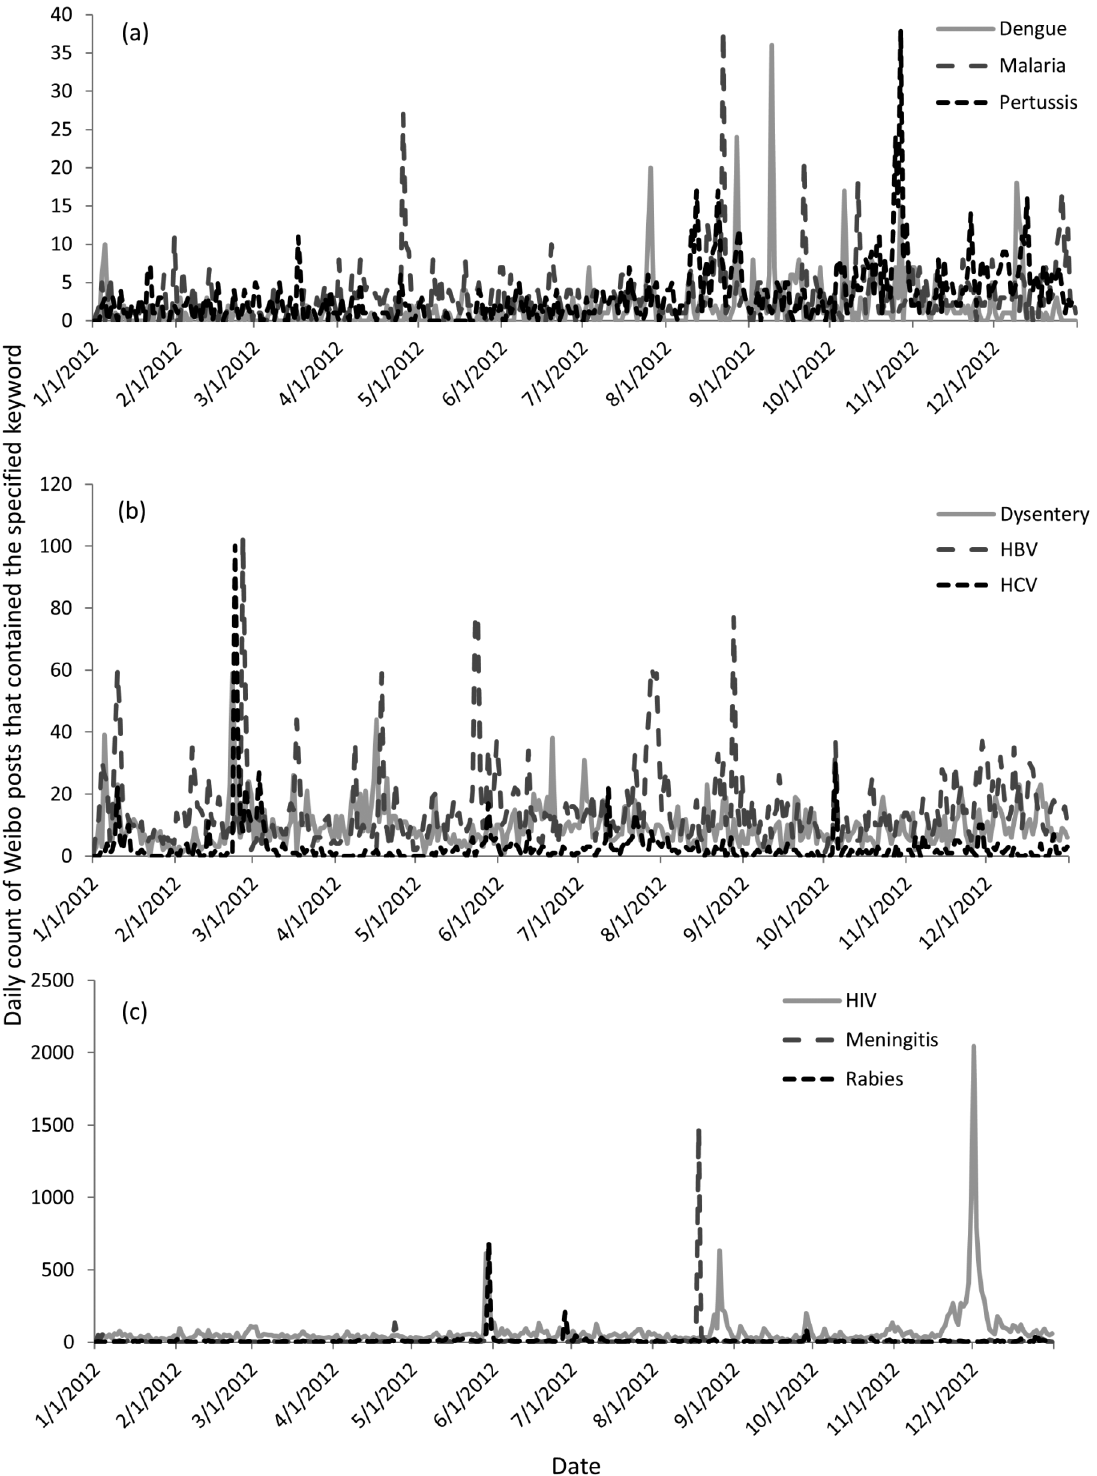
Fig 2. Sample time series of daily count of Weibo posts containing keywords pertaining to selected diseases in 2012 in WeiboScope database (posts generated by Weibo users with 1000 followers or more). Nine diseases are chosen as illustrations for the magnitude of the peaks and are grouped accordingly: (a) dengue, malaria and pertussis; (b) dysentery, hepatitis B and hepatitis C; (c) HIV, meningitis and rabies.